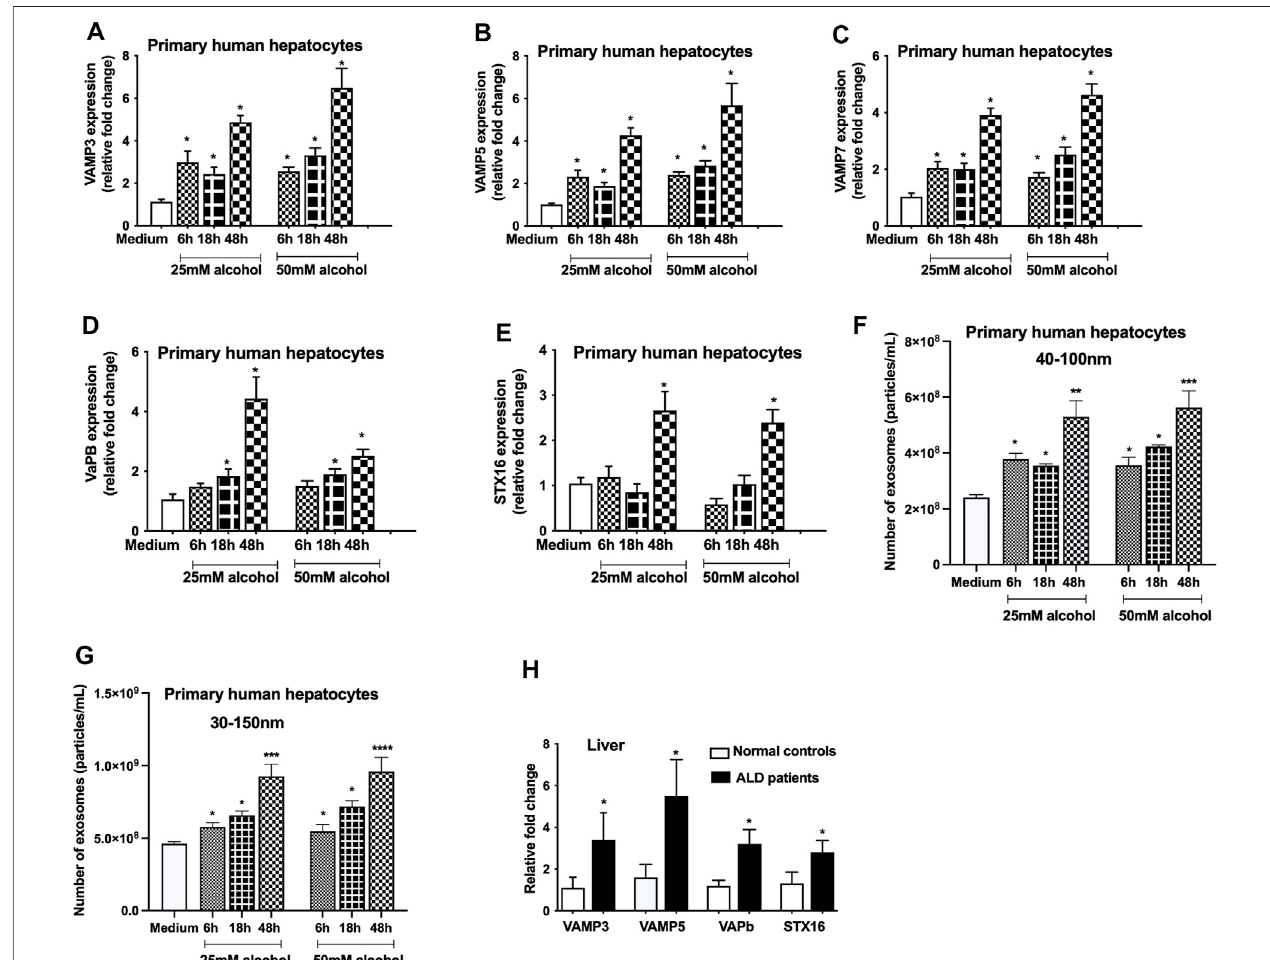
FIGURE 2 | Alcohol increases the expression of VAMPs and syntaxins. Primary human hepatocytes were cultured and treated with different dosage of alcohol (25 and 50 mM) forindicated times andVAMP3 (A) ,VAMP5 (B) , VAMP7 (C) ,VAPb (D) , andSTX16 (E) expression wasassessed byqPCRfrom thetotal RNAisolated from the cells. Total number of particles was measured from the cell free supernatant after alcohol treatment (25 and 50 mM) for indicated times using Nanosight (F and G) . Data is presented as particles/ml. Number of particles from 40 – 100 nm and 30 – 150 nm are represented in F and G, respectively. Total RNA extracted from the livers of normal controls and ALD patients (n (cid:1) 9) was used to determine the expression of VAMP3, VAMP5, VAPb and STX16 by qPCR (H) . 18s was used to normalize the cq values. Data represent mean ± SEM. Mann-Whitney test or one-way ANOVA was used for statistical analysis. *, **, ***,**** indicates p < 0.05, p < 0.005, p < 0.0005, p < 0.0001 compared to control cells (A-G) or normal controls (H) .